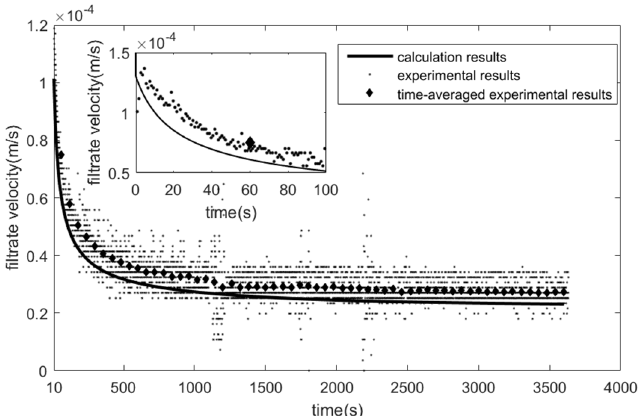
Figure 9. Comparison of the experimental results and calculated results of crossflow filtration.